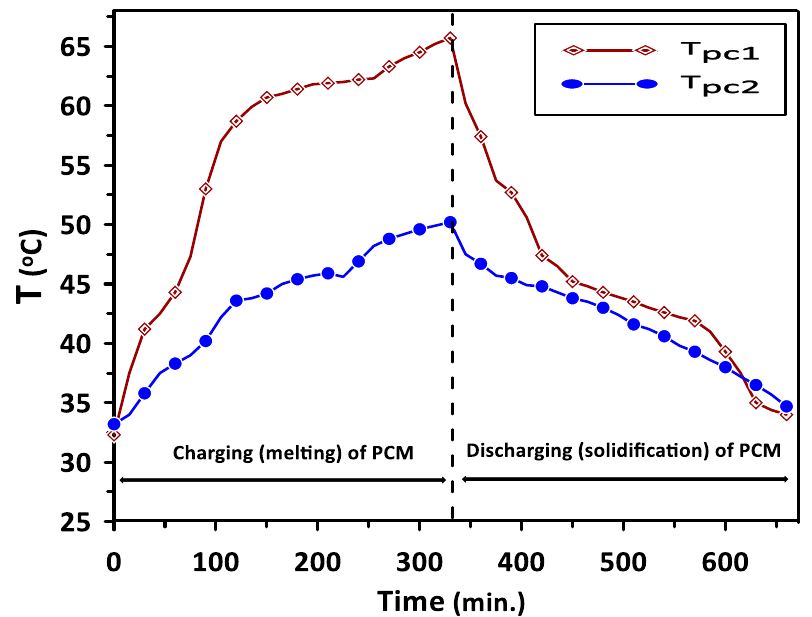
Figure 7. Complete melting and solidification of PCM1 and PCM2 during the charging and discharging cycles.